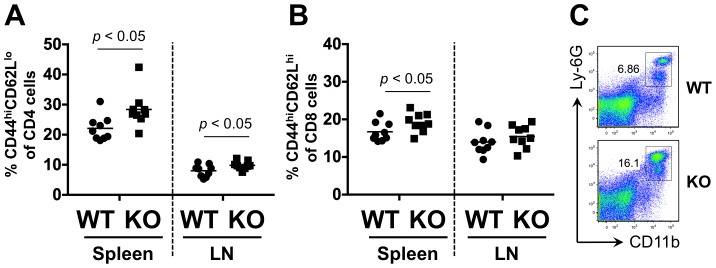
Treg-specific miR-17∼92a deficiency results in immunologic abnormalities.Littermate Mir17∼92afl/fl Foxp3CreYFP/CreYFP(Y) (KO) and Mir17∼92afl/+ Foxp3KI/KI(Y) control (WT) pairs (n = 9) were analyzed at ∼15 weeks of age. T cell populations in the spleen and lymph node were stained for memory phenotype markers. Shown are (A) CD4+ T cells with an effector memory (CD44hiCD62Llo) phenotype, and (B) CD8+ T cells with an activated/central memory (CD44hiCD62Lhi) phenotype. Paired t tests were performed for statistical comparisons. (C) An accumulation of large numbers of granulocytic (CD11b+Ly-6G+) cells can also be observed in the spleens of older KO mice.